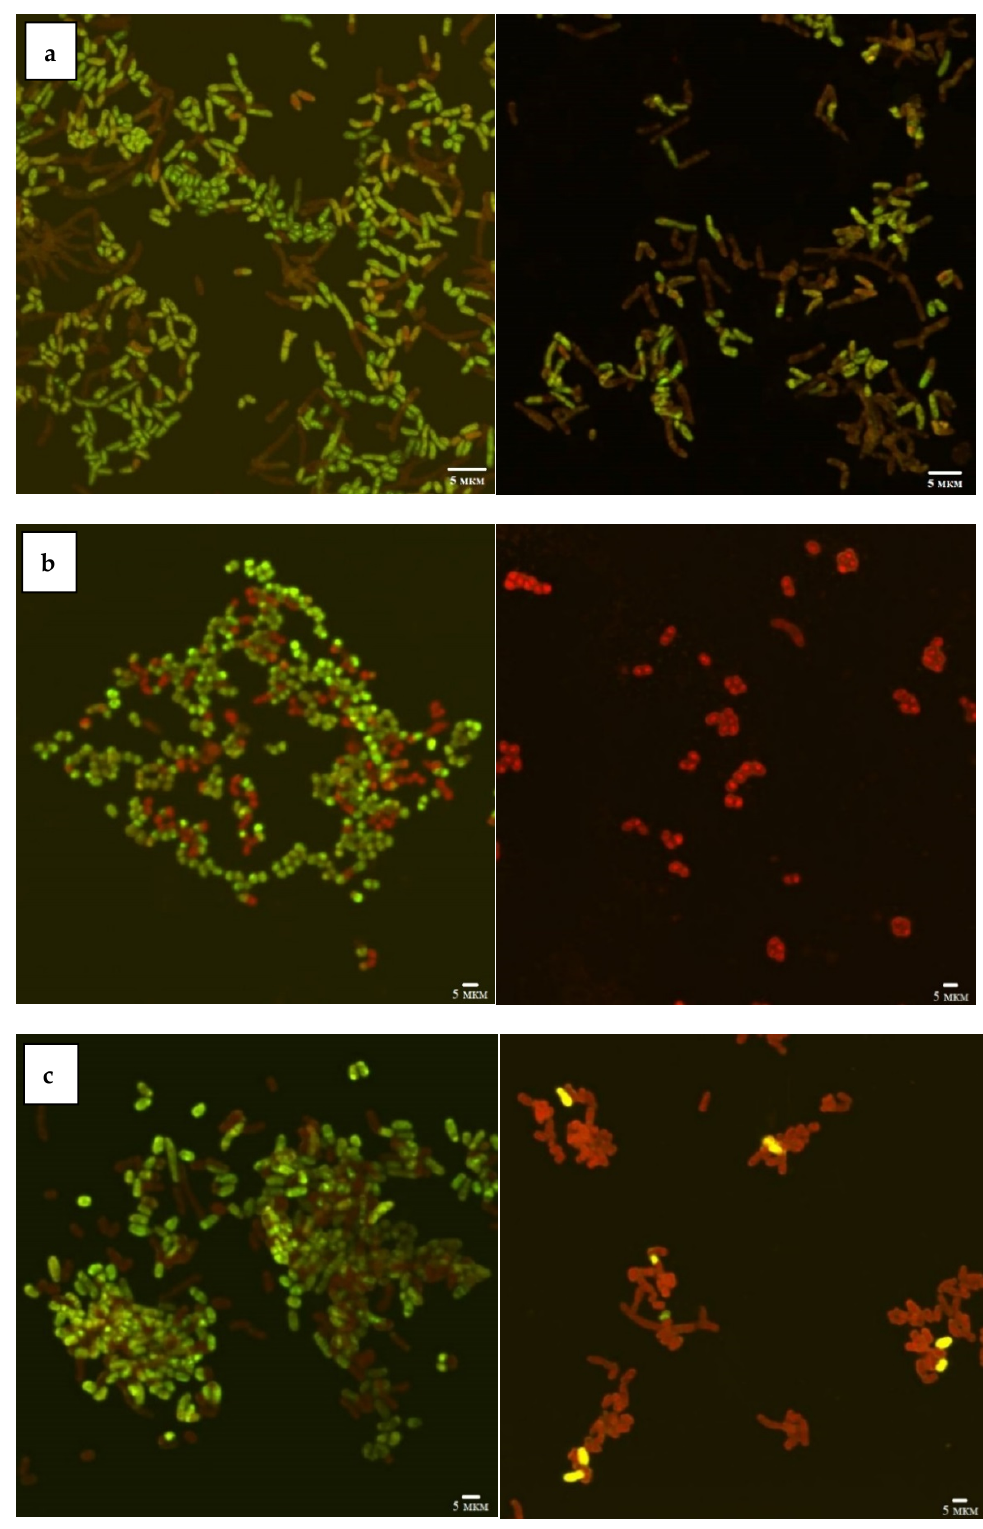
Figure 1. CLSM images of R. opacus IEGM 263 ( a ), R. rhodochrous IEGM 1363 ( b ), R. ruber IEGM 231 ( c ) control cells ( left ) and after 48-h incubation with 1.0 g/L Ni NPs ( right ). Viable cells fluoresce green, dead cells red.